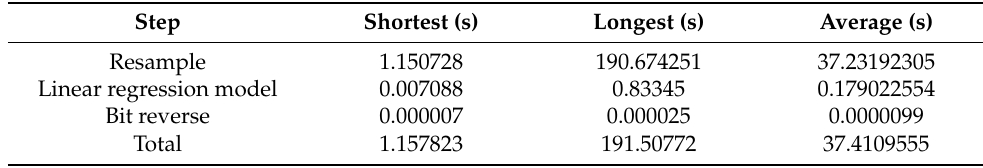
Table 8. Implementation time of each